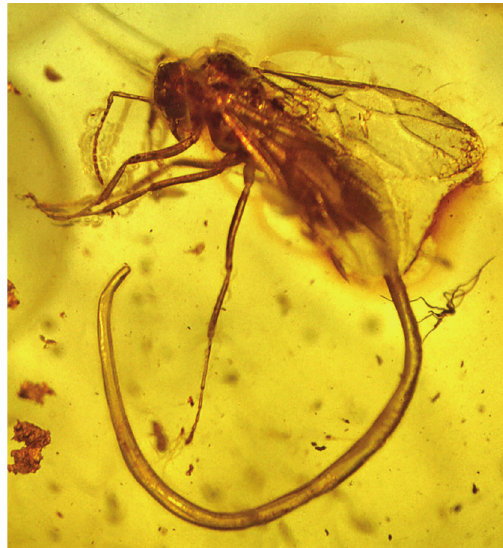
Figure 3: The fossil nematode, Heydenius formicinus, emerging from a male Prenolepis henschei in Baltic amber.